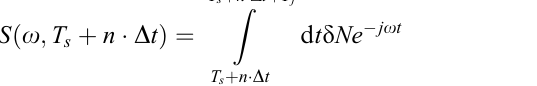
Fig. 2. Curves for di(cid:128)erent heights are artificially shifted